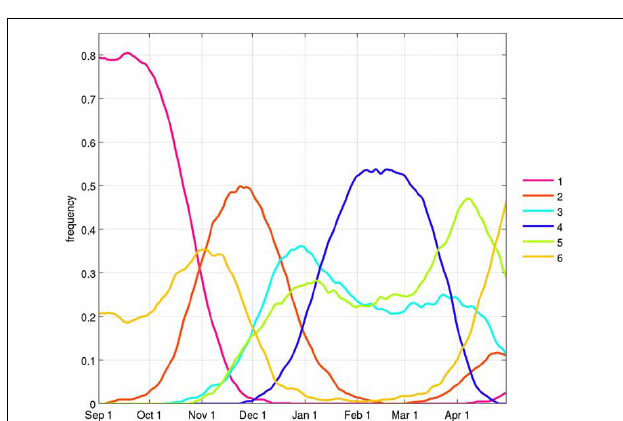
FIGURE 3 | Mean seasonal cycle of the frequency of occurrence of the weather types (WTs). The daily frequency is low-pass filtered with a 31-day running